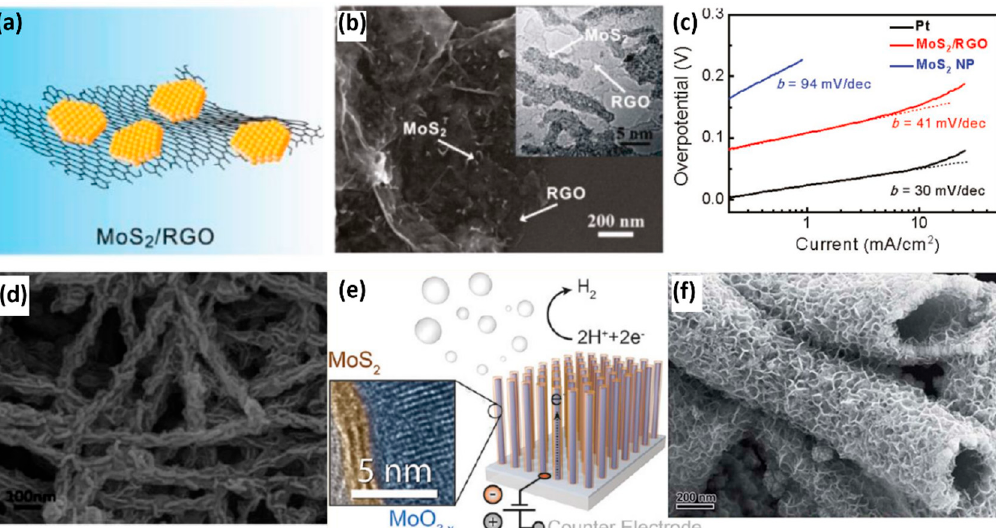
Figure 6. ( a ) Schematic illustration and ( b ) SEM image of the MoS 2 /rGO hybrid [58]. The inset in ( b ) is the corresponding TEM image. ( c ) Tafel plots of several catalysts with a loading of 0.28 mg/cm 2 as indicated [58]. ( d ) SEM image of the MoS 2 /CNT composite [59]. ( e ) Left: HRTEM image of MoO 3 /MoS 2 heterostructure. Right: schematic illustration of the HER catalytic activity in the MoO 3 /MoS 2 heterostructure [60]. ( f ) SEM image of MoS 2 /SnO 2 nanotube heterostructure [61]. Reproduced from [58,60] with permission from copyright 2011. American Chemical Society and [59,61] with permission from copyright The Royal Society of Chemistry.